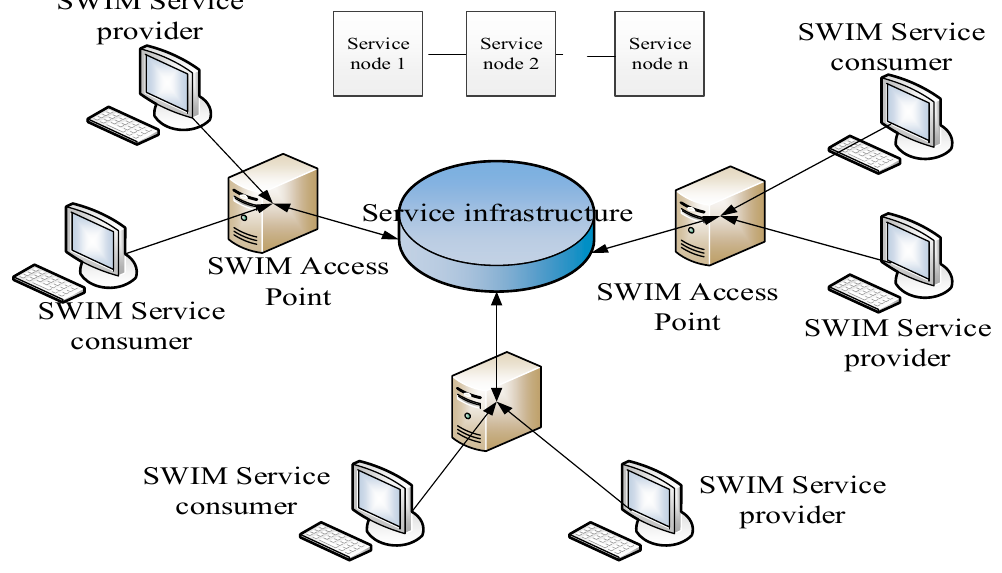
Figure 8. Experimental test environment.